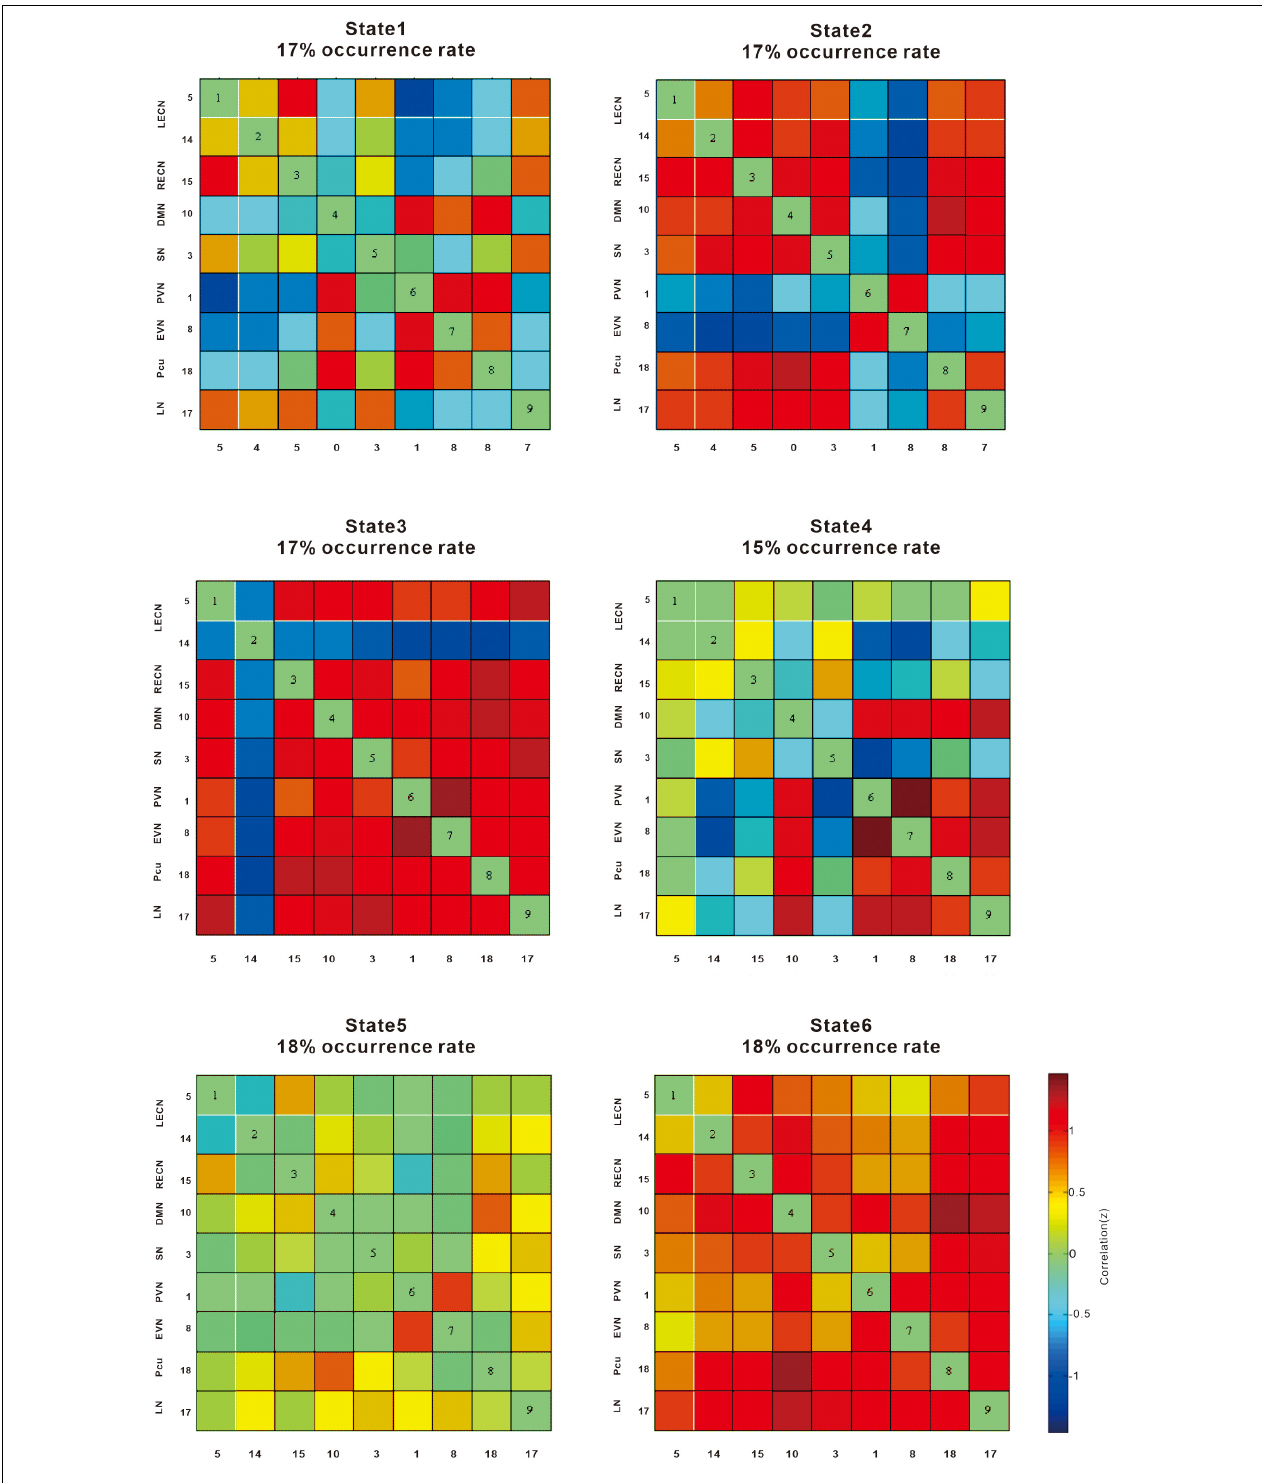
FIGURE 4 | The correlation (z) provides information on the effect size. The cool color scale represents negative values, indicating hypoconnectivity (decreased positive correlation, or greater anti-correlation) in patients with type 2 diabetes mellitus (T2DM) relative to normal controls (NCs); the hot color scale represents positive values, indicating hyperconnectivity (increased positive correlation or less anti-correlation) in patients with T2DM relative to NCs. LECN, left executive control network; RECN, right executive control network; Pcu, precuneus network; PVN, primary visual network; EVN, extrastriate visual network; LN, language network; SN, salience network, DMN, default mode